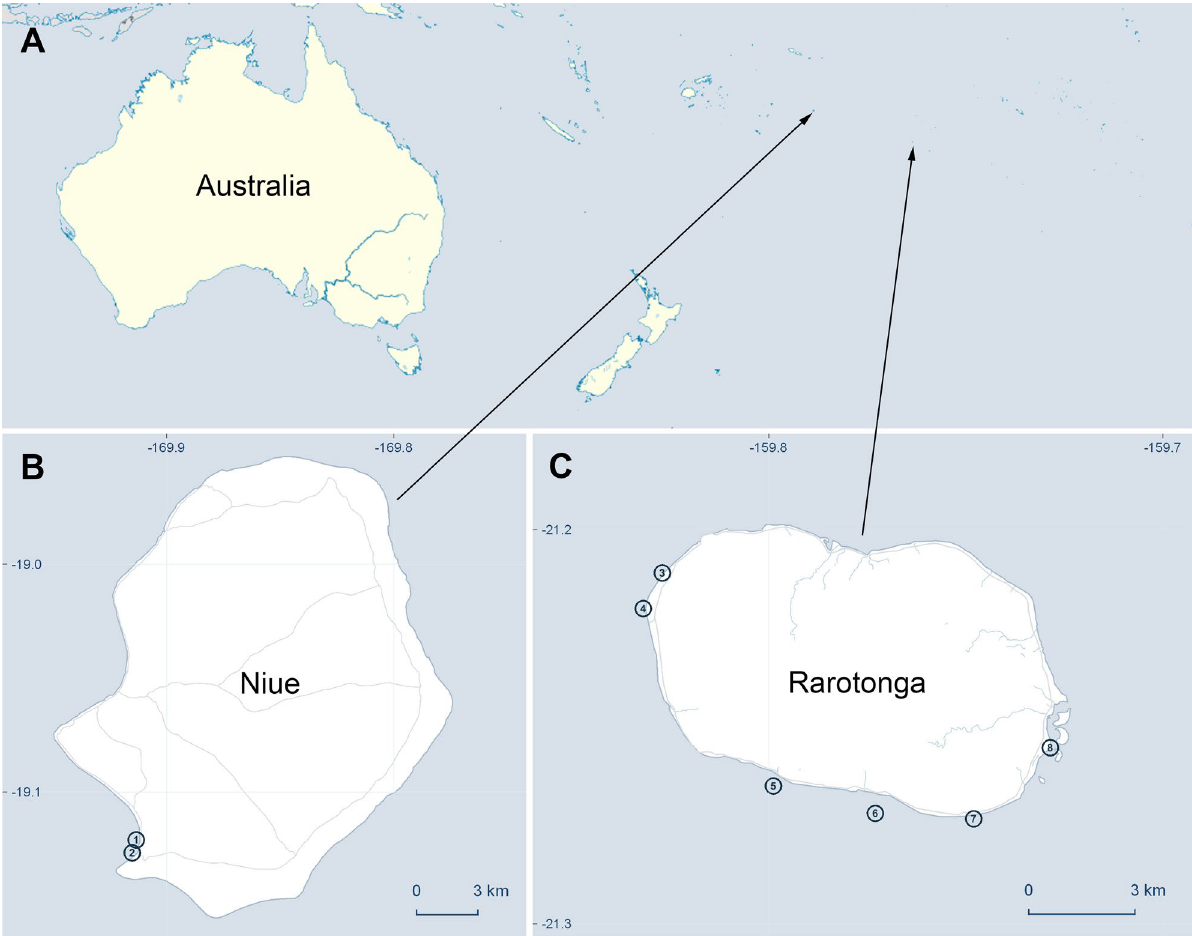
Figure 1. Map of the sampling sites. ( A ) Locations of Niue Island and Rarotonga, Cook Islands in the South Pacific Ocean. ( B ) Sampling sites at Niue Island (1. Avatele Beach, 2. Tamakautoge Beach). ( C ) Sampling sites Rarotonga, Cook Islands (3. Black Rock, 4. Sheraton Passage, 5. Papua Passage, 6. Queen’s Residence, 7. Titikaveka and 8. Muri